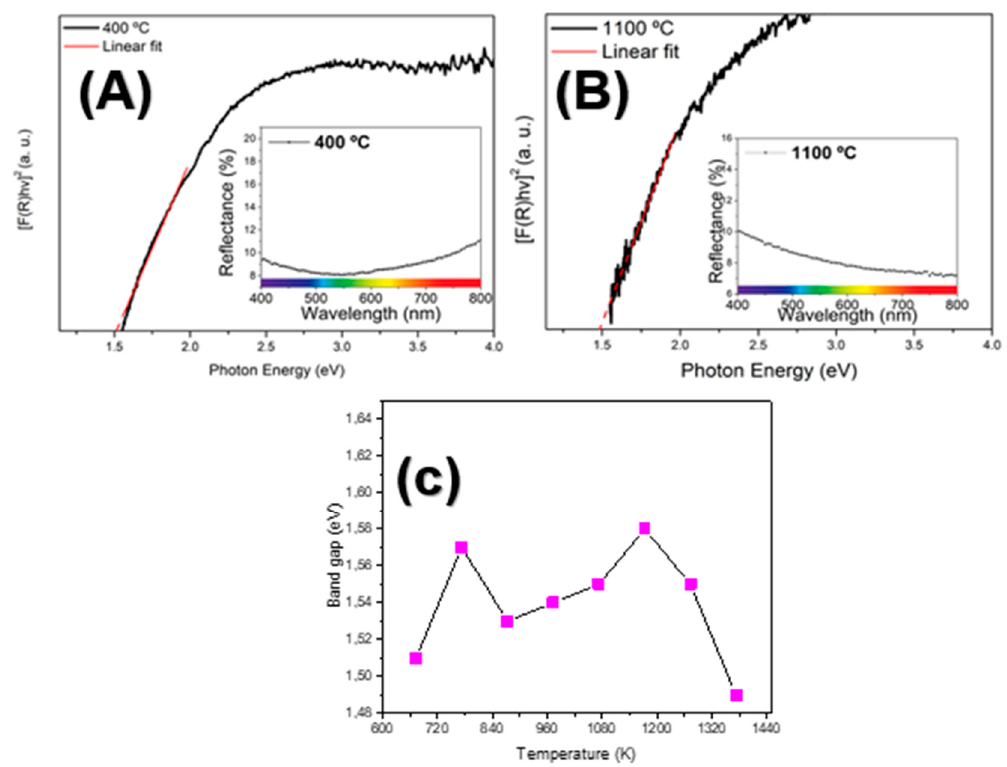
Figure 8. The UV–Vis spectra and energies of the optical band gap of the heat-treated CuFe 2 O 4 samples: ( A ) 400 °C, ( B ) 1100 °C, ( C ) optical band gap energies of CuFe 2 O 4 as a function of calcination temperature. Table 2. A comparison of the CuFe 2 O 4 obtained in the work with others reported in the literature with the same conditions.